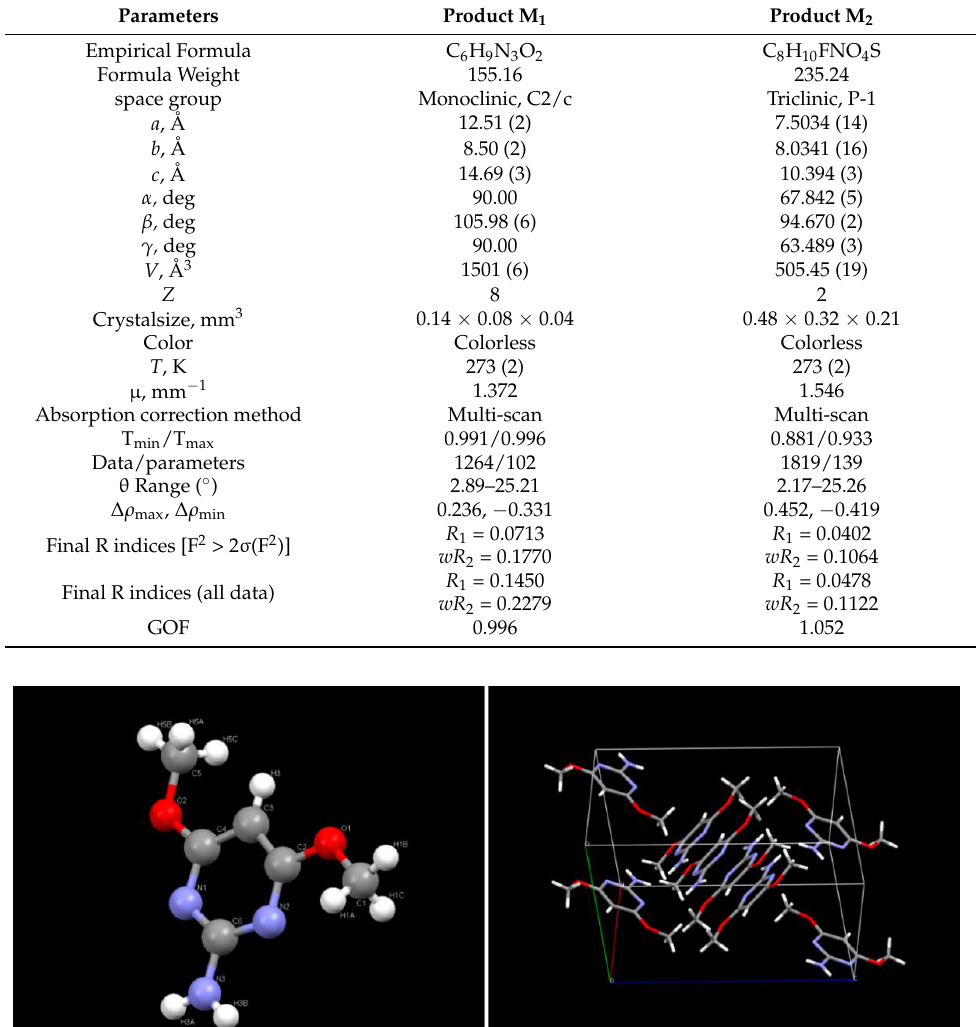
Figure 3. X-ray Crystal structure of product M1 and packing of M1 within a unit crystal cell.